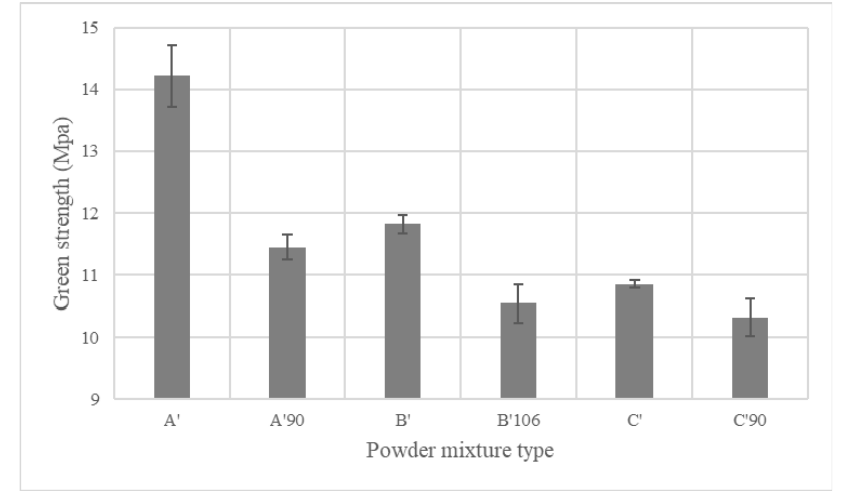
Figure 10. Green strength for various PMS mixtures (including 0.7 wt. % of the lubricant).